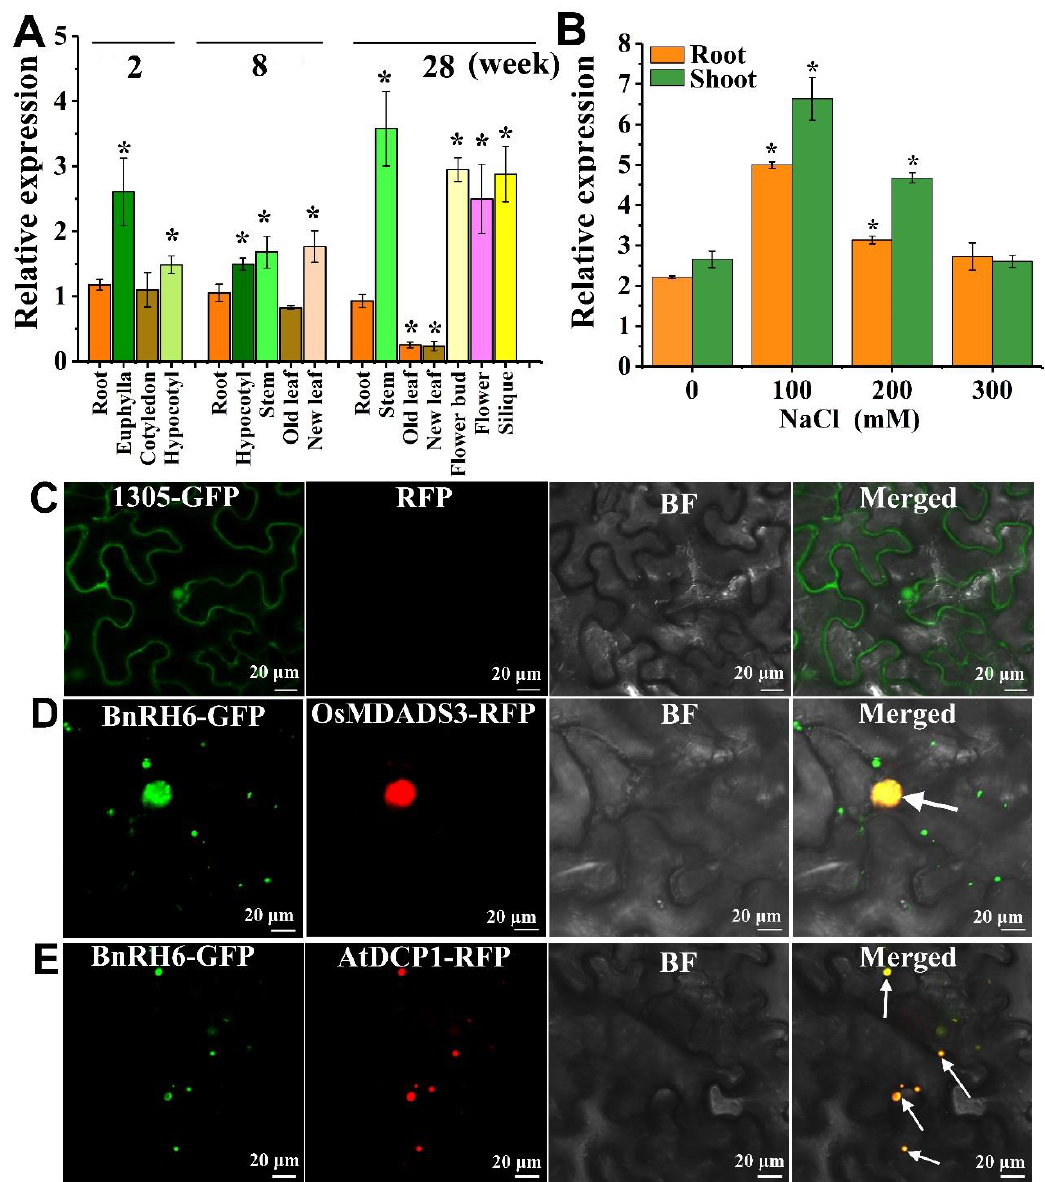
Figure 1. Analysis of BnRH6 transcripts and subcellular localization in Brassica . ( A ) Transcript levels of BnRH6 at different tissues or organs of Brassica across the life circle were determined by qRT-PCR. ( B ) BnRH6 was transcriptionally induced under salt stress. Two-week-old seedlings were treated with 0, 100, 200, and 300 mM NaCl for 6 h. Vertical bars represent mean values ± SD (standard deviation) (*, p < 0.05, Student’s t- test). ( C – E ): the subcellular localization assay was conducted with tobacco leaves. ( C ): BnRH6-GFP fluorescence only. ( D ): BnRH6-GFP fusion was co-expressed with the nuclear marker (OSMDADS3-RFP). ( E ): BnRH6-GFP fusion was co-expressed with P-body marker (DCP1-RFP). The arrows pointed to the merged fluorescent signals. BF: bright field. Scale bar = 20 μm.